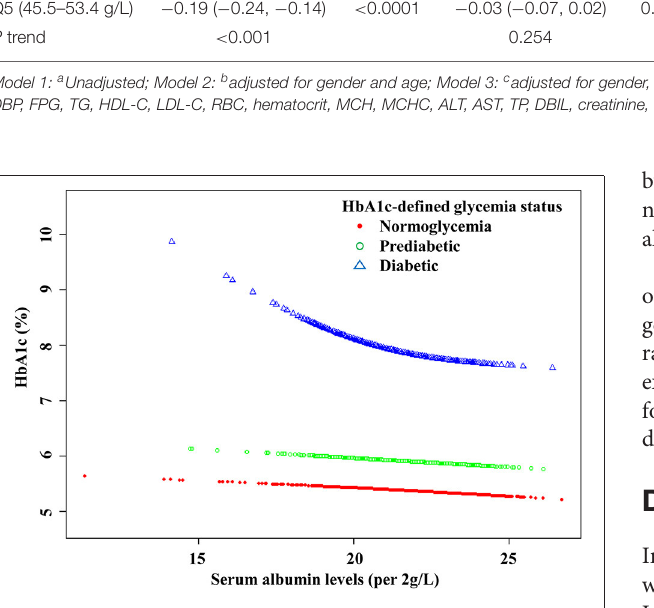
FIGURE 1 | The curved lines illustrate the association between the serum albumin levels and HbA1c. A threshold, nonlinear association between serum albumin levels (per 2 g/L increment) and HbA1c was found (P < 0.0001) using a generalized additive model. The model was adjusted for gender, age, BMI, pulse, SBP, DBP, TG, HDL-CH, LDL-CH, FPG, RBC, HCT, MCH, MCHC, ALT, AST, TP, DBIL, creatinine, BUN, and